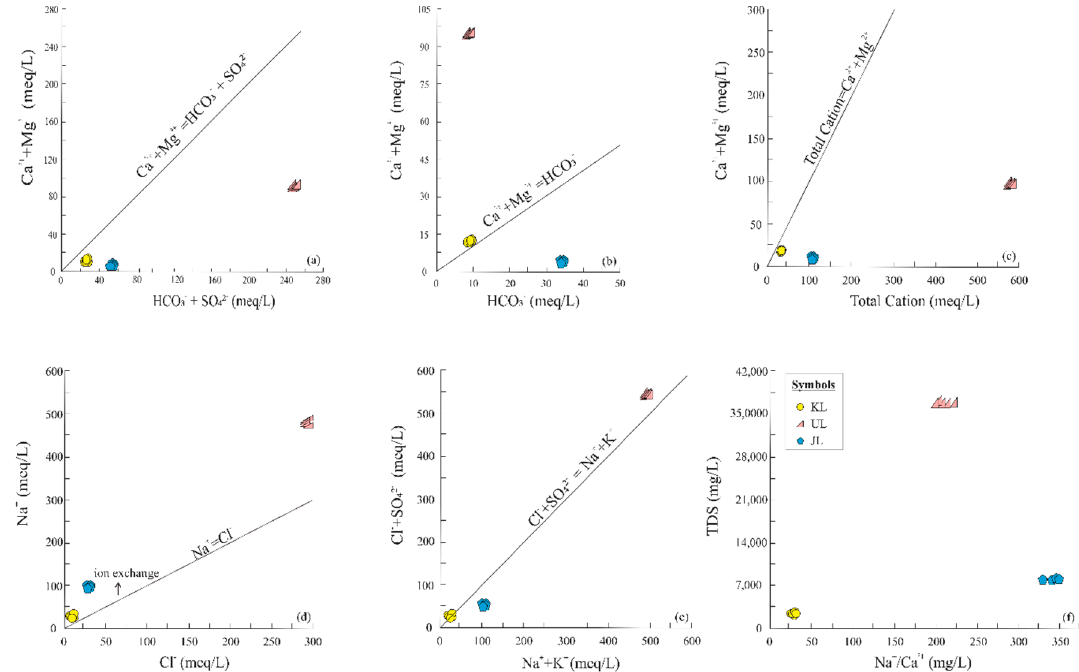
Figure 4. Ion relationships in the lakes’ water samples.